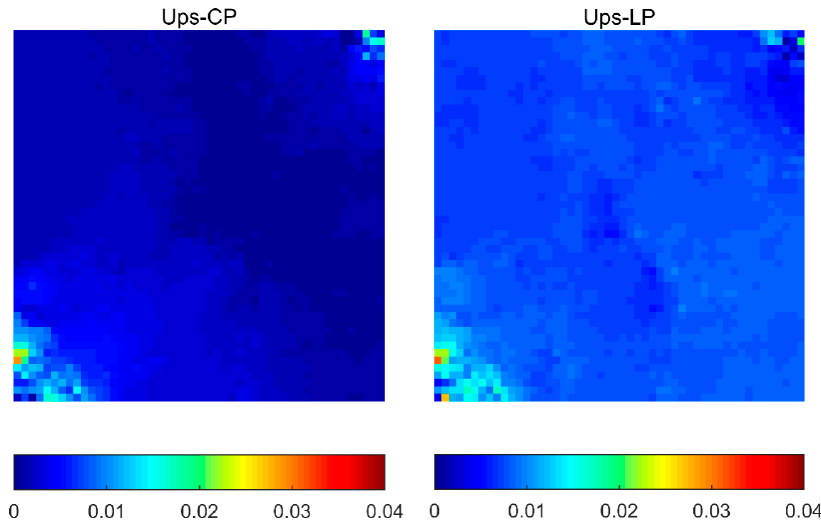
Figure 19. Case 3: relative error of pressure solutions for Ups-CP ( left ) and Ups-LP ( right ).